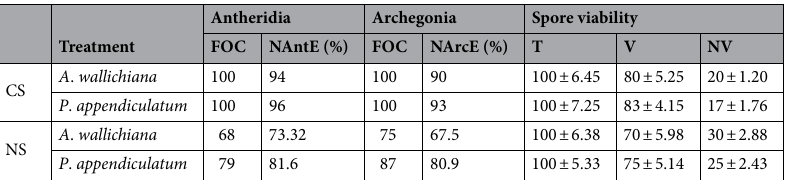
appendiculatum (20%) in NS, when compared with CS (Table 3). The carotenoid (CAR) content was decreased in A . wallichiana by 32% and increased in P . appendiculatum by 38% in NS compared with CS (Table 3). How-